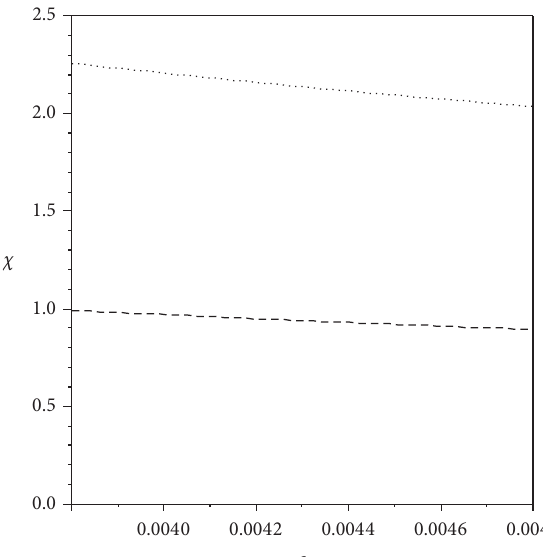
Figure 3: The variation of 𝜒 defined by (28) versus the parameter 𝜖 . The values of the parameters are V 𝑠 = 1 and V 𝑝 = 1.2 . For the dashed curve the values of the parameters are 𝑡 = 𝑞 = 0.1 and for the dotted curve are 𝑡 = 𝑞 = 0.2